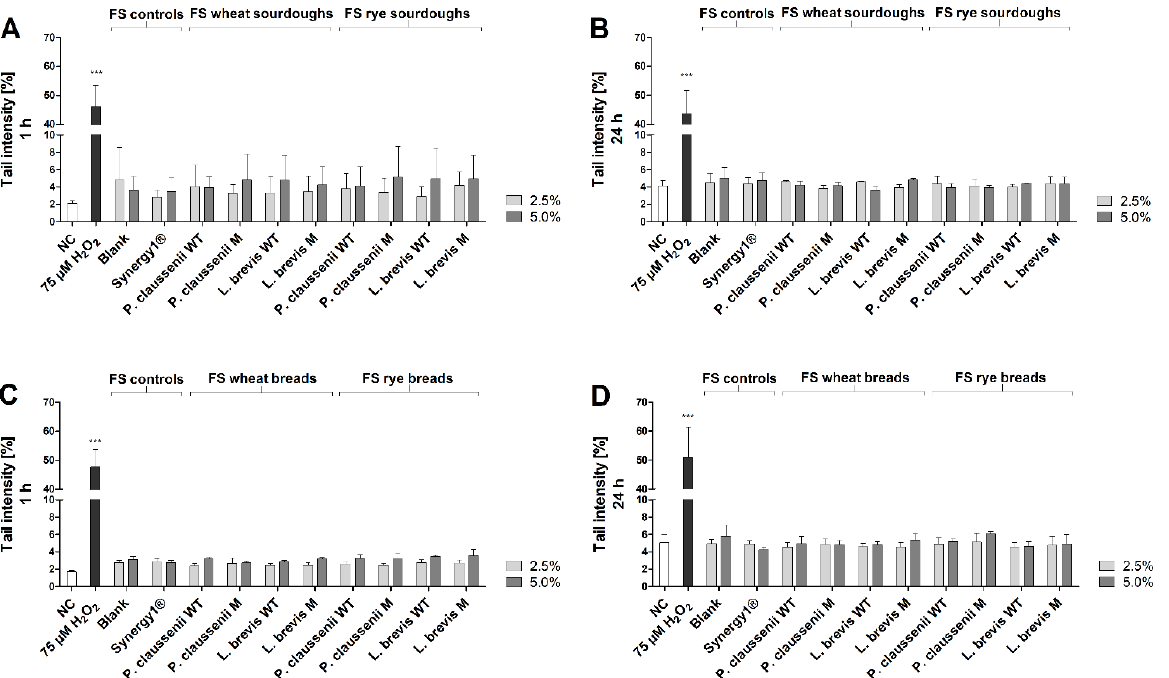
Figure 5. Tail intensity [%] after treatment of LT97 cells with 2.5% and 5% fermentation supernatants (FS) obtained from controls (blank, Synergy1 ® ) and wheat and rye sourdoughs for 1 h ( A ) and 24 h ( B ) and with FS obtained from controls (blank, Synergy1 ® ) and wheat and rye breads for 1 h ( C ) and 24 h ( D ) (mean + SD, n = 3). Sourdoughs and breads were generated using wild-type (WT) and mutant (M) strains of Pediococcus claussenii (WT: TMW 2.340, M: TMW 2.2123) and Levilactobacillus brevis (WT: TMW 1.2112, M: TMW 1.2320). Significant differences between cells treated with FS and negative controls (NC, PBS (1 h)/medium (24 h)) were checked using the one-way ANOVA. Significant differences between NC and positive control (75 µM H 2 O 2 ) were obtained by unpaired Student’s t-test ( *** p < 0.001). TMW: Technische Mikrobiologie Weihenstephan.